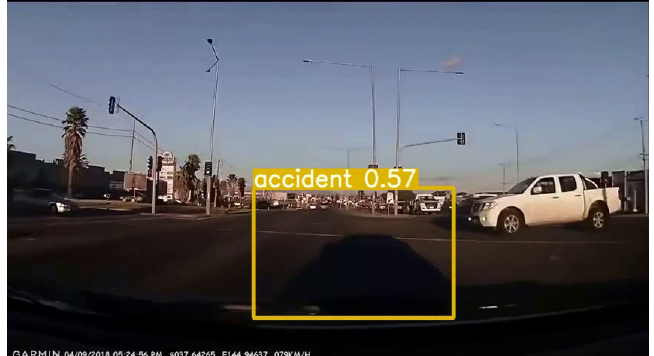
Figure 6. Example of the detection of the vehicle’s shadow as the collided